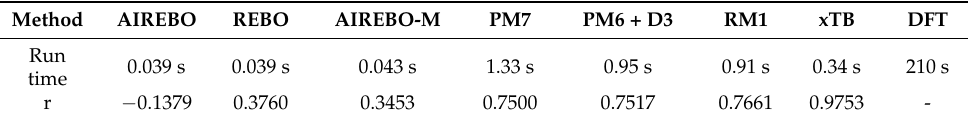
Table 2. Comparison of empirical and semi-empirical methods with DFT. Run time is the average of 10 runs for pure C 20 . r is Pearson’s correlation coefficient